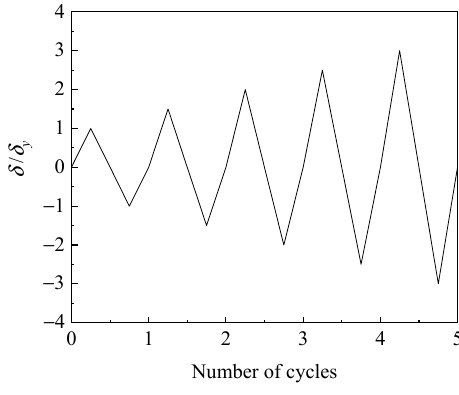
Figure 8. Loading pattern I.